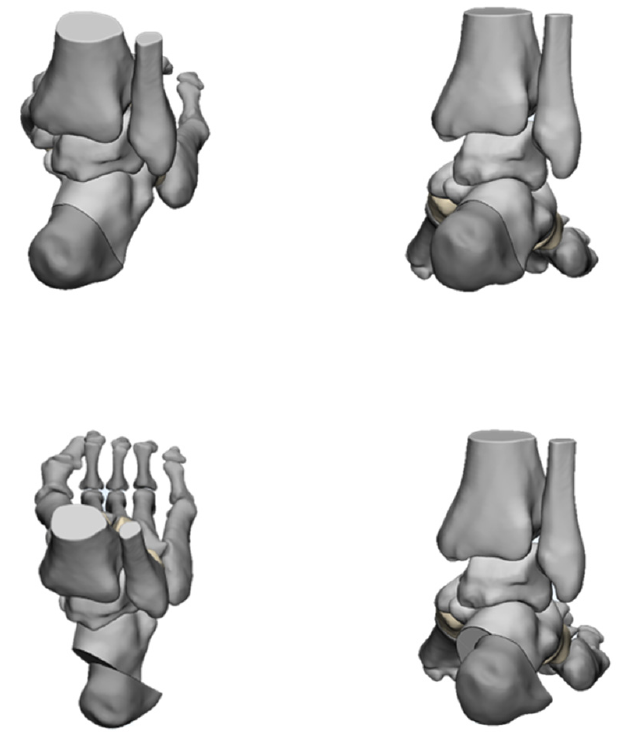
Figure 16. The oblique calcaneus Osteotomy.